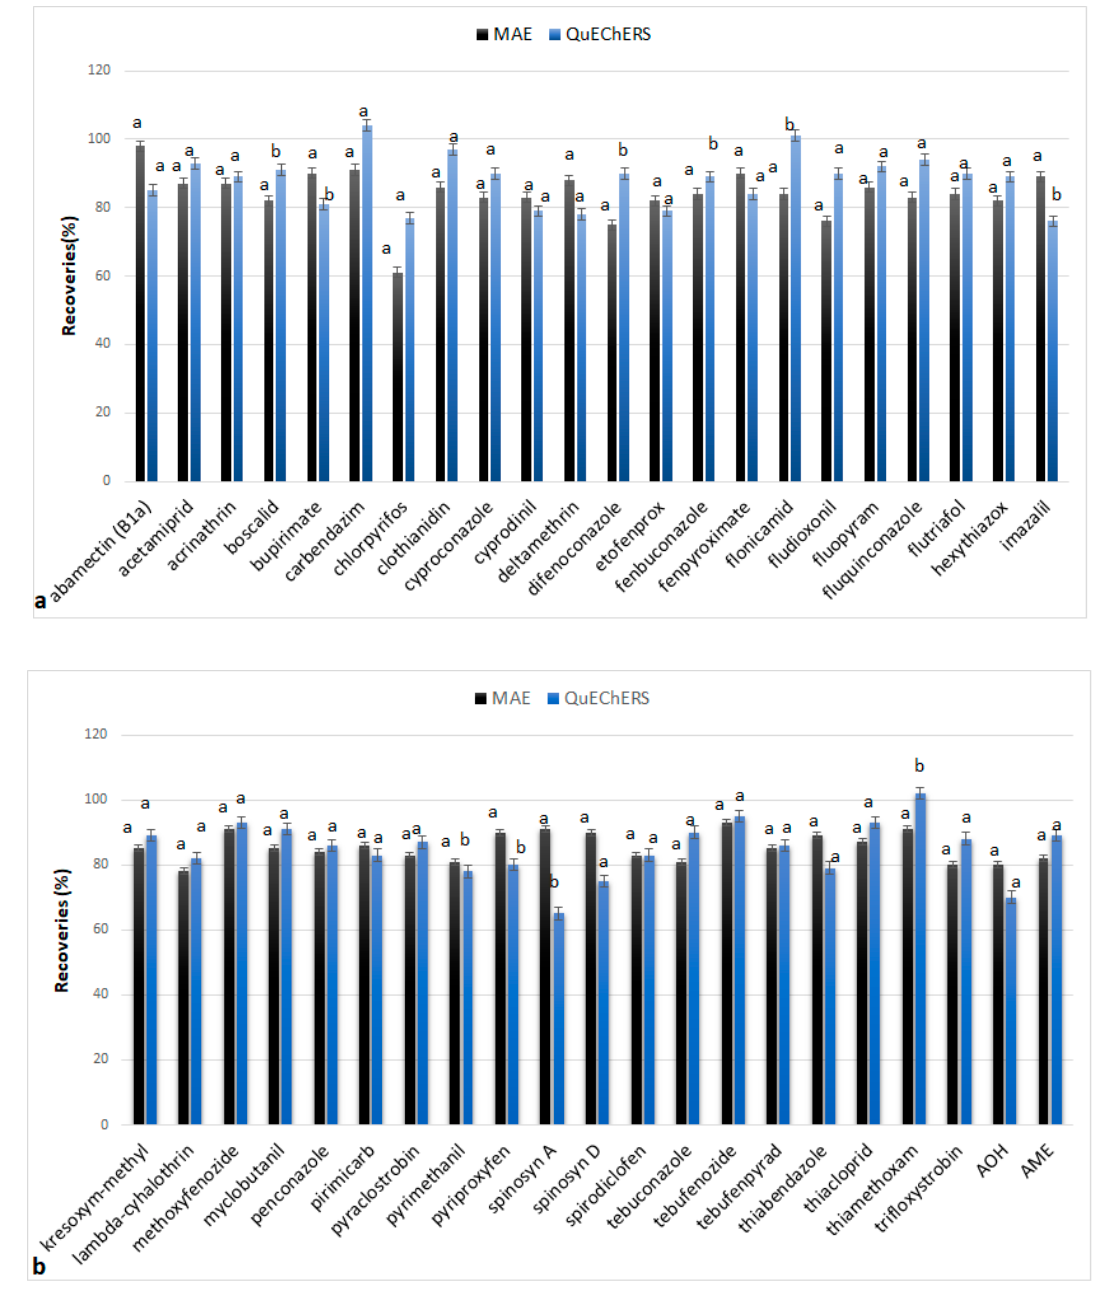
Figure 7. Recoveries (%) extracted by QuEChERS and MAE methods at 0.1 µ g/g concentration level for the analytes: ( a ) abamectin (B1a), acetamiprid, acrimathrin, boscalid, bupirimate, carbendazim, chlorpyrifos, clofentezine, clothianidin, cyproconazole, cyprodinil, deltamethrin, difenoconazole, etofenprox, fenbuconazole, fenpyroximate, flonicamid, fludioxonil, fluopyram, fluquinconazole, flutriafol, hexythiazox, imazalil; ( b ) kresoxym-methyl, lambda-cyhalothrin, methoxyfenozide, myclobutanil, penconazole, primicarb, pyraclostrobin, pyrimethanil, pyriproxyfen, spinosyn A, spinosyn D, spirodiclofen, tau-fluvalinate, tebuconazole, tebufenozide, tebufenpyrad, thiabendazole, thiacloprid, thiamethoxam, trifloxystrobin, alternariol (AOH), alternariol monomethyl ether (AME). The values for each analyte followed by the same letter show that the two methodologies do not differ significantly statistically ( p < 0.05).